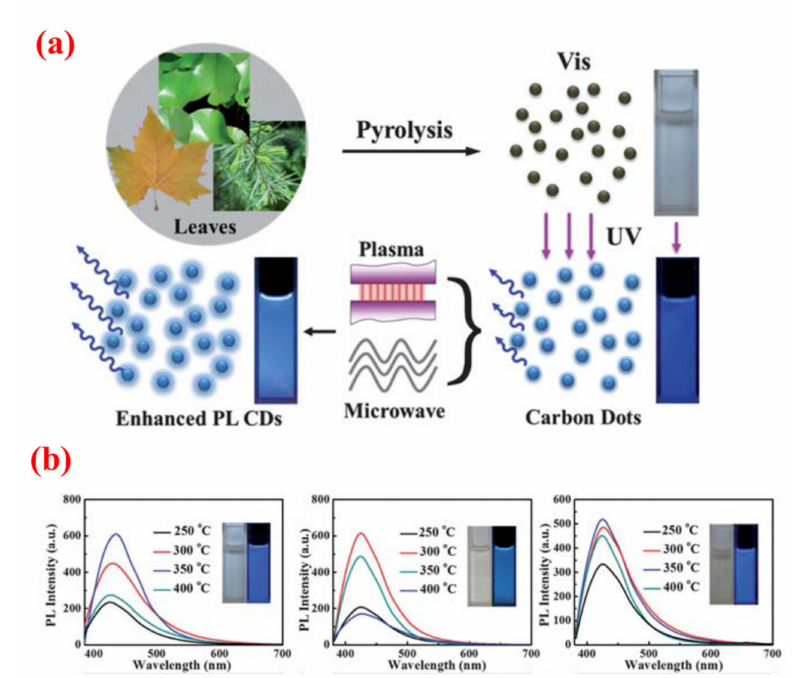
Figure 8. ( a ). Schematic illustration of the synthetic process of C-dots from di ff erent plant leaves by the pyrolysis method [97]; ( b ). The fluorescence emission spectra of the corresponding C-dots (obtained from oriental plane leaves, lotus leaves and pine needles successively from left to right) synthesized under di ff erent pyrolysis temperatures